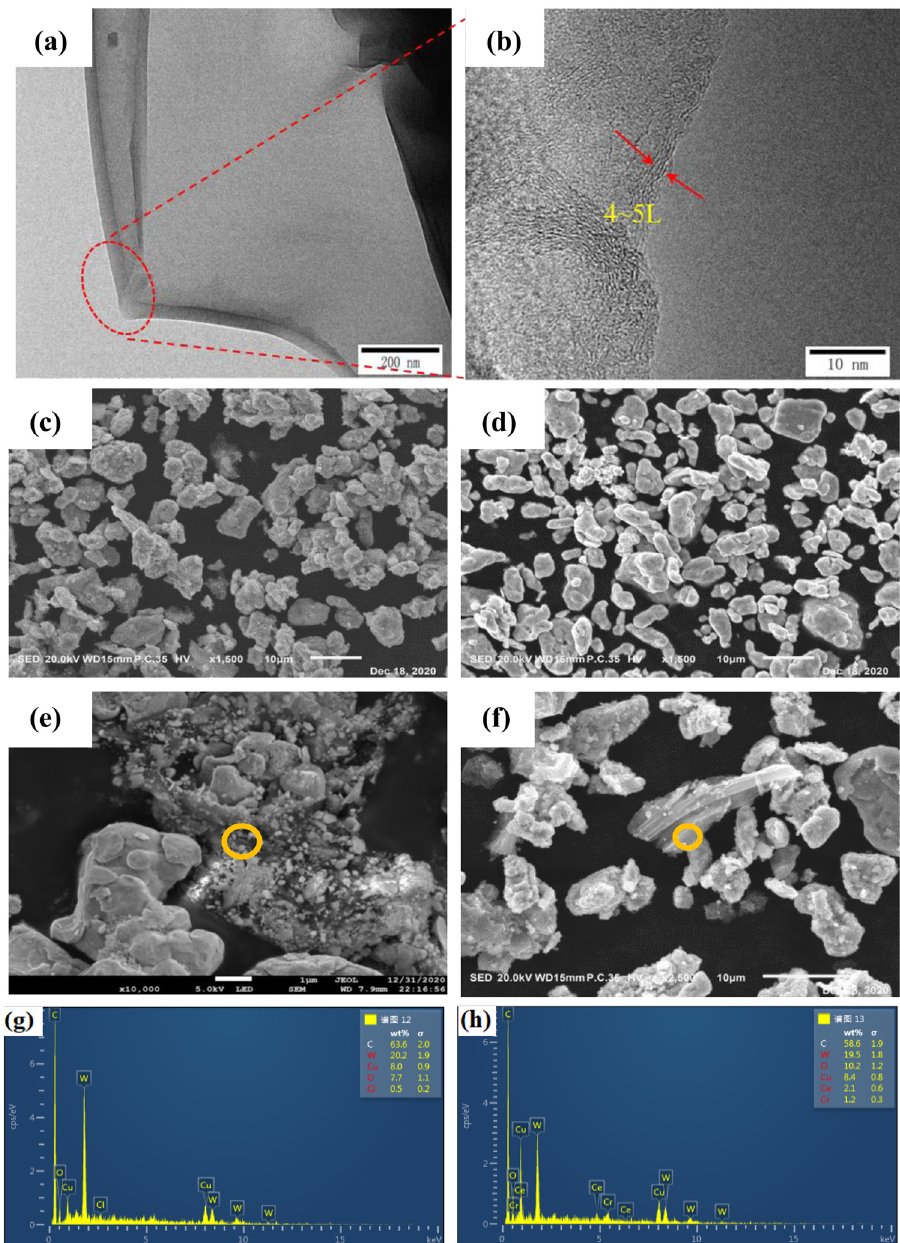
Figure 1: Morphology of GO and composites powder: ( a and b ) TEM of GO fl akes; ( c, e, and g ) SEM morphology and EDS results of 0.5GO/ 0.5CeO 2 – Cu30Cr10W; ( d, f, and h ) SEM morphology and EDS resultsof 1.0GO/0.5CeO 2 –